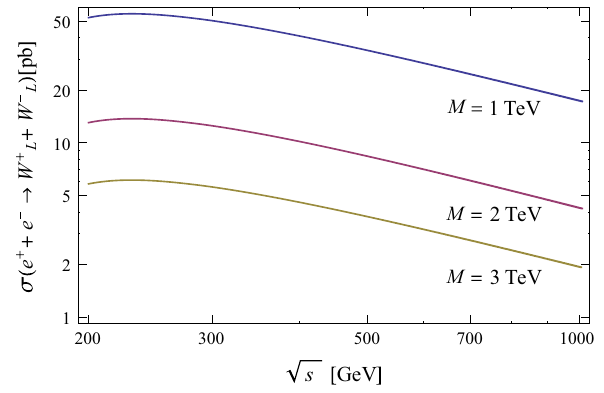
Fig. 7 The total cross section for e − e + → W + W − scattering as a function of the electron–positron center-of-mass energy 1 , 2 and 3 TeV at c 3 / 2 = 1. Cases with c 3 / 2 (cid:8)= 1 can be reached via the W − scattering. The L L rescaling M → M / c 3 /